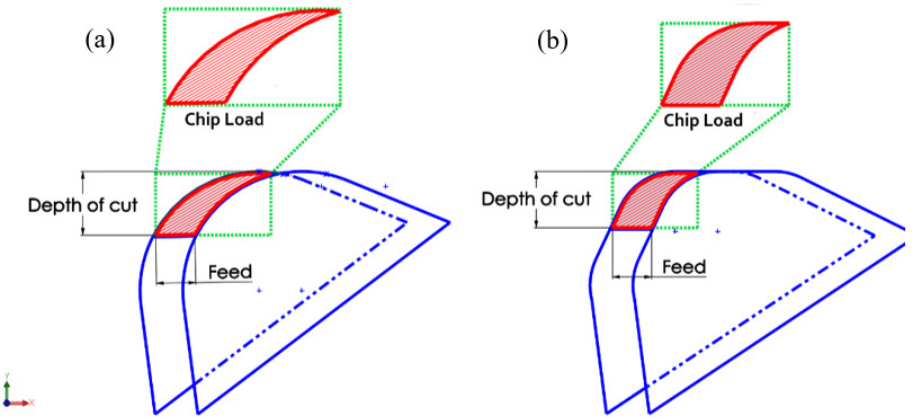
Figure 11. Comparison of the machining action and the geometry of the chip for the ( a ) conventional and ( b ) wiper inserts at the same depth of cut and feed.